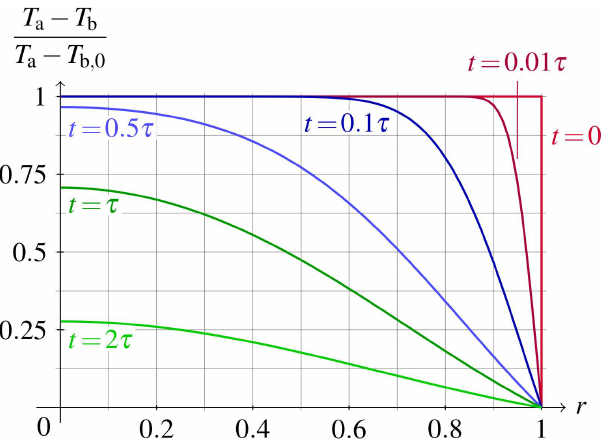
Fig. A1. Radial distribution of the quantity on the left-hand side of Eq. (A2) at different times. τ = R 2 /(π 2 D) denotes the characteris- tic time of diffusion. Table A1. Typical values of some parameters associated with the balloon at two different altitudes. The lifting gas is assumed to be hydrogen, whose specific heat capacity at constant pressure equals 1 . 4 × 10 5 Jkg − 1 K − 1